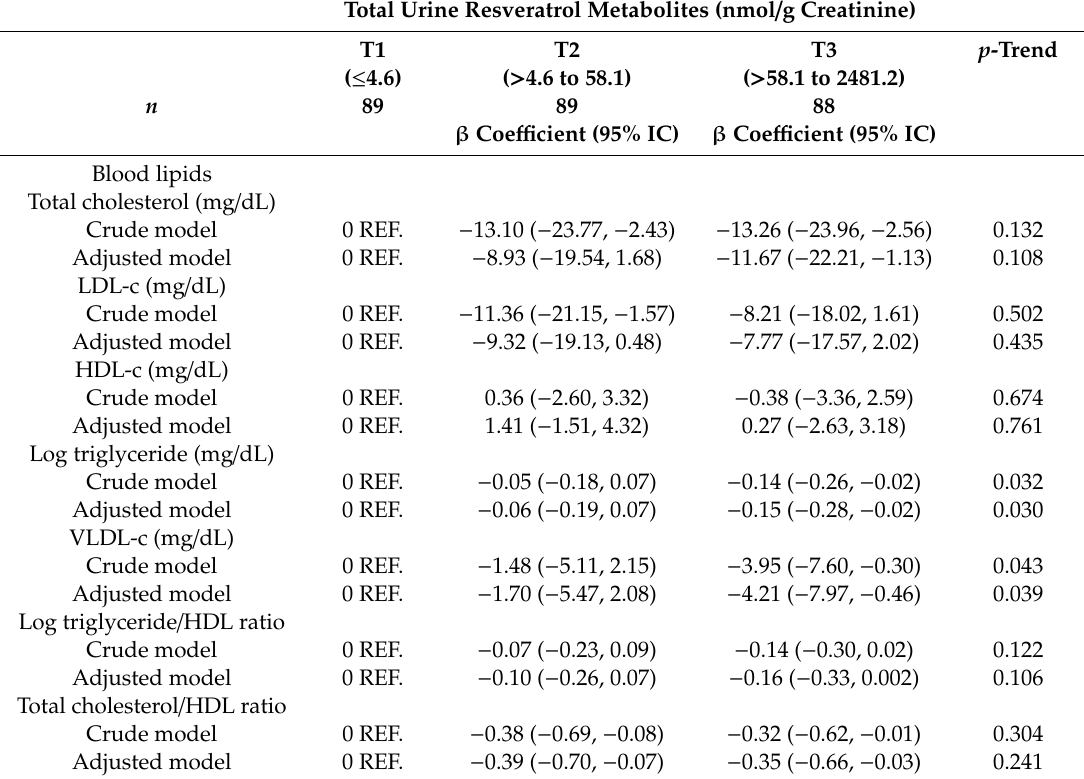
Table 4. Linear regression analysis evaluating the associations between total urine resveratrol (independent variable) and blood lipids (outcome) in participants with